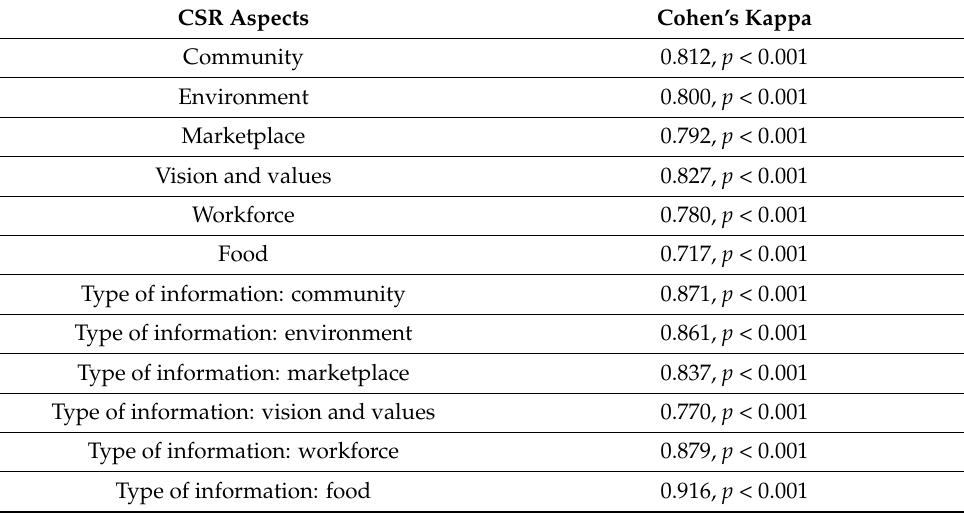
Table 3. Results of intercoder reliability.